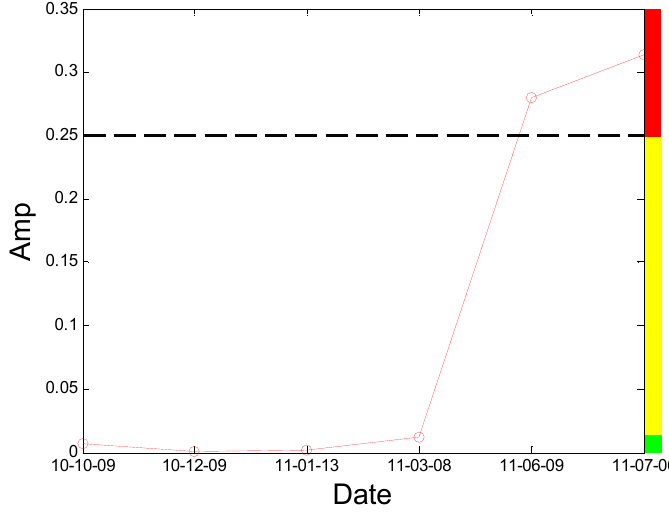
Figure 12. The results by the quantitative identification index on A fan No. 2H sensor.